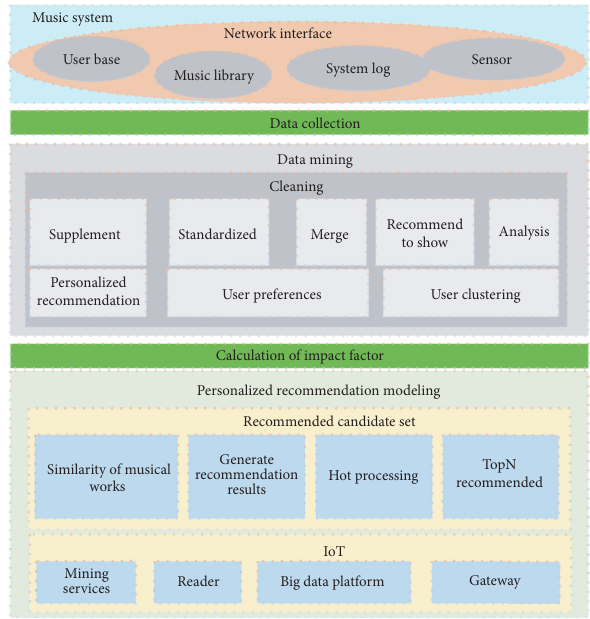
Figure 1: Personalized recommendation process of data mining